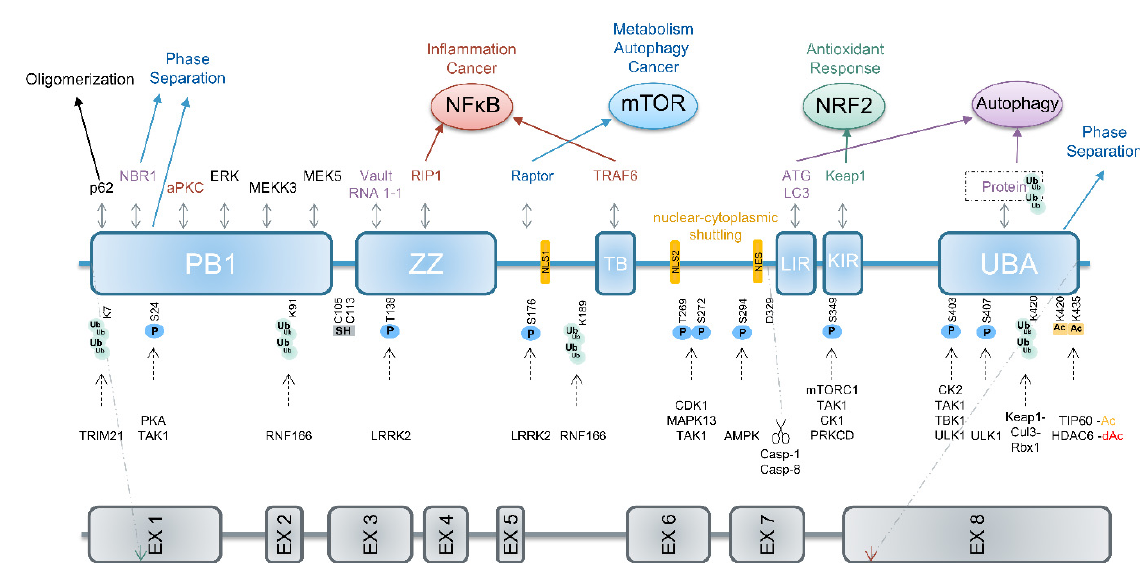
Figure 1. Structure of SQSTM1 and p62. Domain architecture of p62, posttranslational modifications, binding/modifying proteins and pathways regulated by p62. The PB1 domain mediates oligomerization and activation of p62, UBA-mediated dimerization holds p62 inactive. For phase separation, the PB1 and UBA domains are required. The role of p62 as a cargo receptor in autophagy is mediated by the LIR motif, linking it to LC3 on autophagosomes, and the UBA domain, which binds to ubiquitinated cargos. Upon phosphorylation at Ser349, the KIR motif interacts with Keap1, thereby liberating Nrf2 and inducing Nrf2 target gene expression. When Raptor binds to p62, mTOR is activated inducing metabolic pathways. Binding of RIP1 to the ZZ or TRAF6 to the TB motif supports activation of NF- κ B. Cleavage after Asp329 by caspase-8 (casp-8) or caspase-1 (casp-1) generates an amino terminal fragment of p62 activating mTOR. Disulfide bond formation involving Cys105 or Cys113 as well as binding of vault RNA1-1 via the ZZ motif supports autophagy. Please see in the text for details. Abbreviations: Ac: acetylation, dAc: de-acetylation, C: Cys, D: Asp, K: Lys, KIR: Keap1-interacting region, LIR: LC3-interacting region, NES: nuclear export signal/sequence, NLS: nuclear localization signal/sequence, PB1: Phox